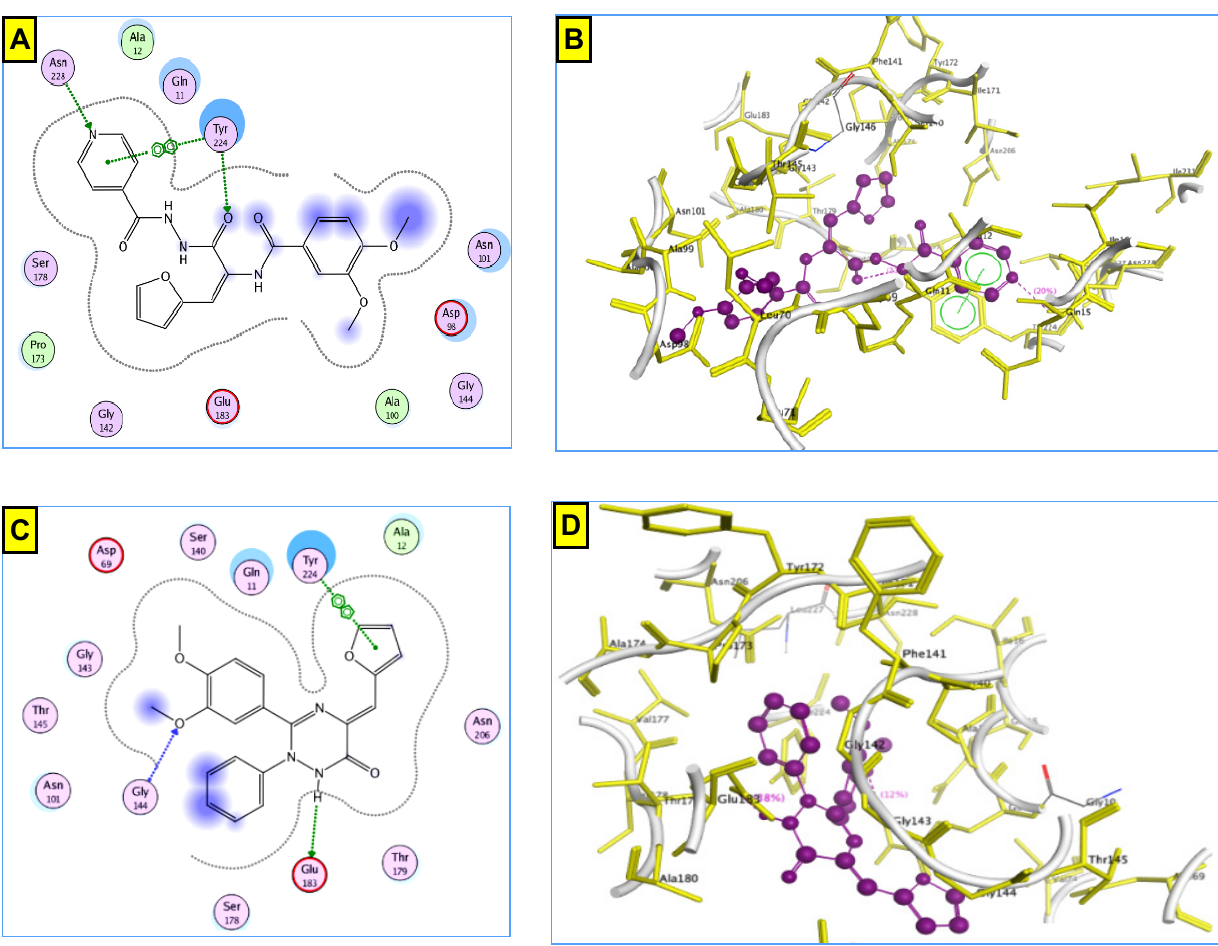
Figure 7. ( A , C ) show the 2D interaction of compounds 4 and 7 , respectively, while ( B , D ) show the 3D interaction of compound 4 and 7 with the amino acid of the tubulin active site.